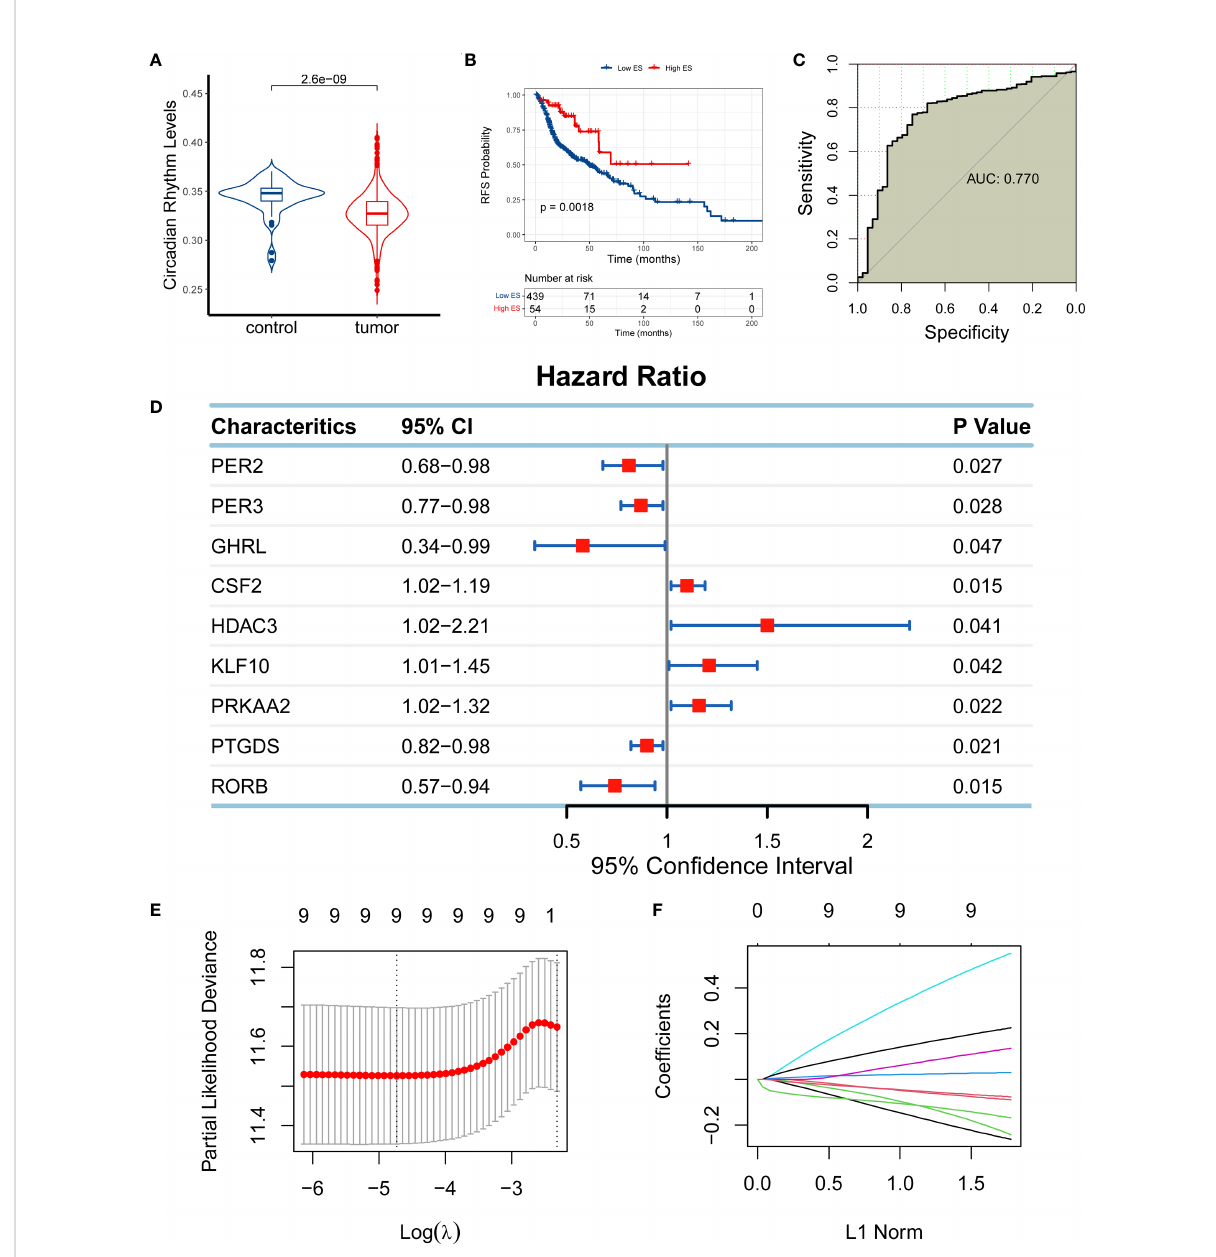
FIGURE 1 Establishment of a circadian rhythm (CR)-related gene signature in head and neck squamous cell carcinoma (HNSC). (A) The enrichment score (ES) of the CR-related gene set was signi fi cantly reduced in HNSC samples compared with normal samples adjacent to the cancer. (B) High-ES patients had an improved overall survival (OS) compared with their counterparts. (C) The CR-related gene set was positively enriched in normal tissue compared with tumor tissue. (D) Nine CR-related genes quali fi ed for univariate Cox regression analysis ( PER2 , PER3 , GHRL , CSF2 , HDAC3 , KLF10 , PRKAA2 , PTGDS , and RORB ; P < 0.05). (E, F) Nine quali fi ed genes were further validated using least absolute shrinkage and selection operator regression analysis to eliminate multicollinearity for the establishment of a CR-related gene signature for predicting OS in HNSC